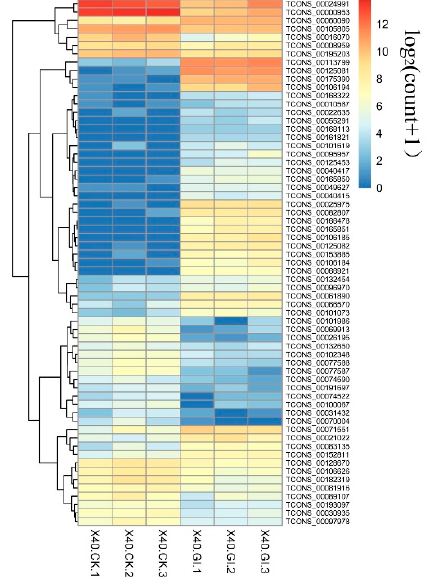
Figure 5. Heatmap of the differentially expressed lncRNAs. X40.CK, roots without fungal inoculation; X40.GI, roots inoculated R. irregularis . “1, 2, 3” represent biological replicates.